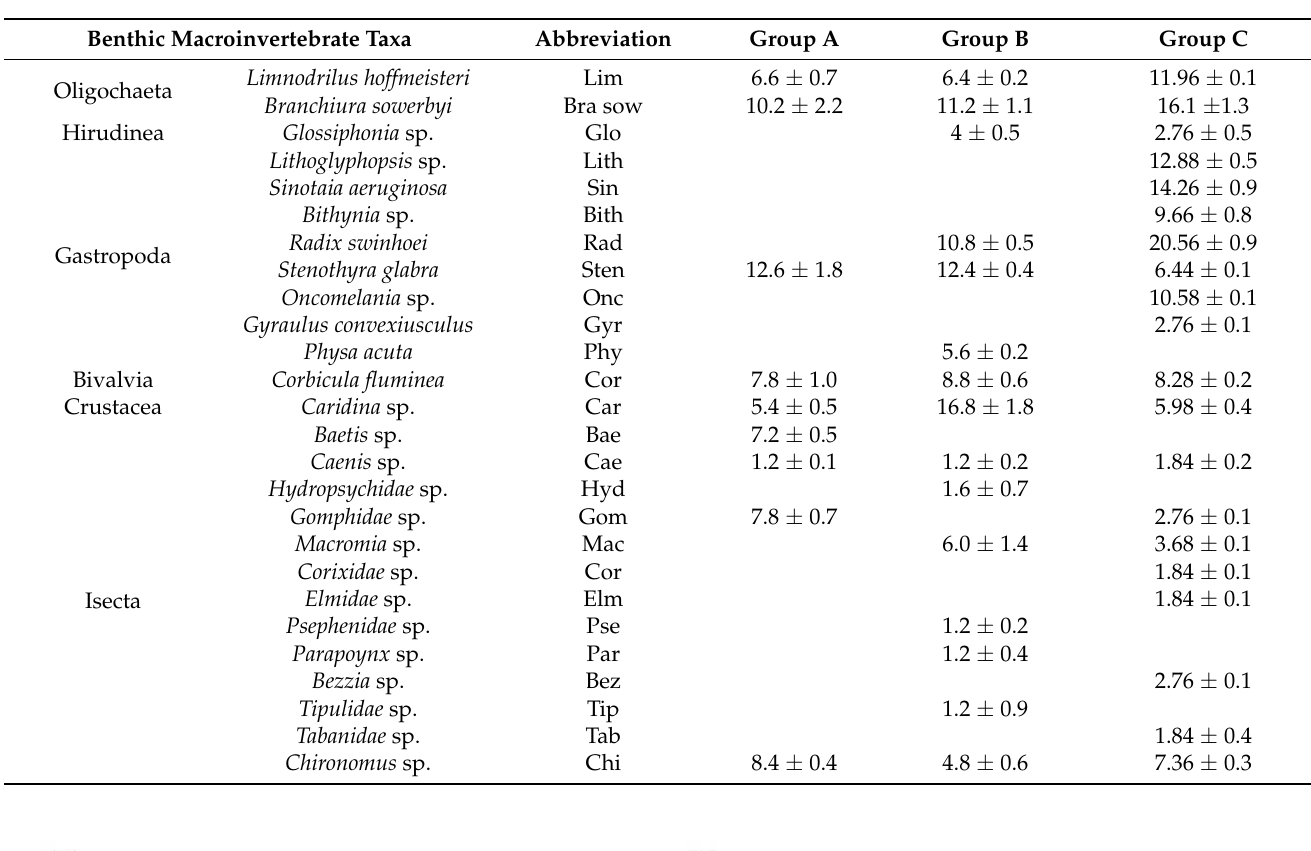
Table 2. Macroinvertebrate taxa and mean abundance (no. of individuals per square meter) at sampling sites along stretches of rivers representing three different phases of construction of inland waterways. Group A is the stretch of an operational inland waterway, Group B is the stretch of a waterway under construction, and Group C is the undisturbed stretch of the river. Data are expressed as means ± SE.